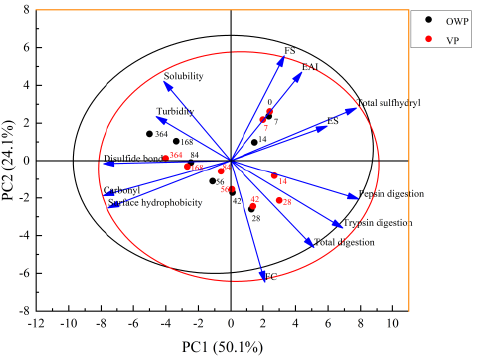
Figure 6. Loading plot of the first two principal components of yak rumen smooth muscle protein properties as affected by OWP and VP packaging treatments.